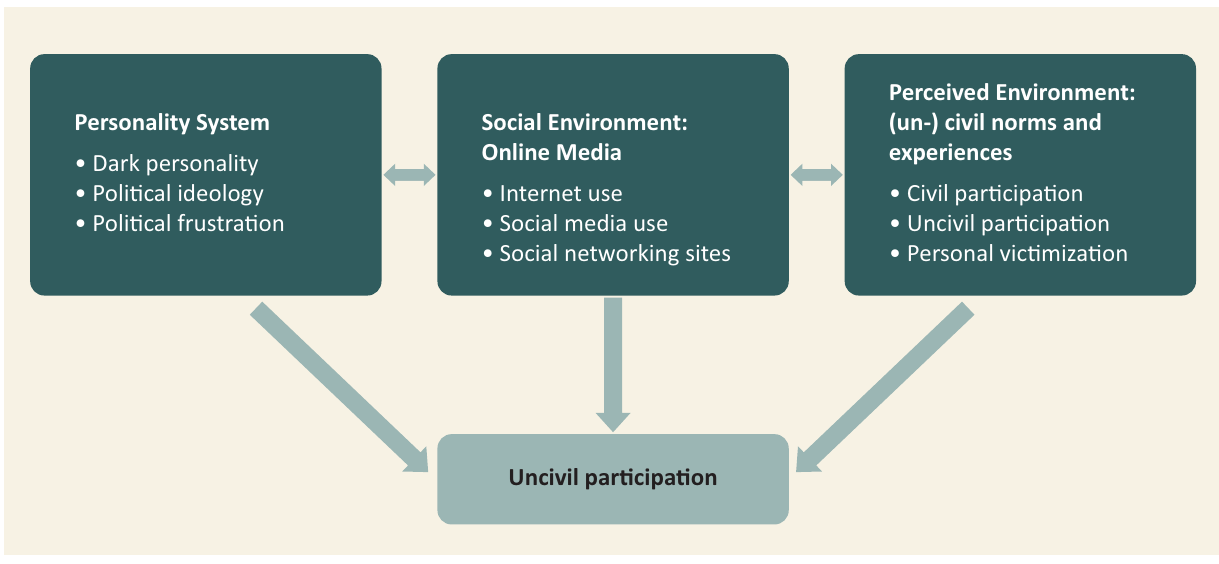
Figure 1. Predictors of uncivil online